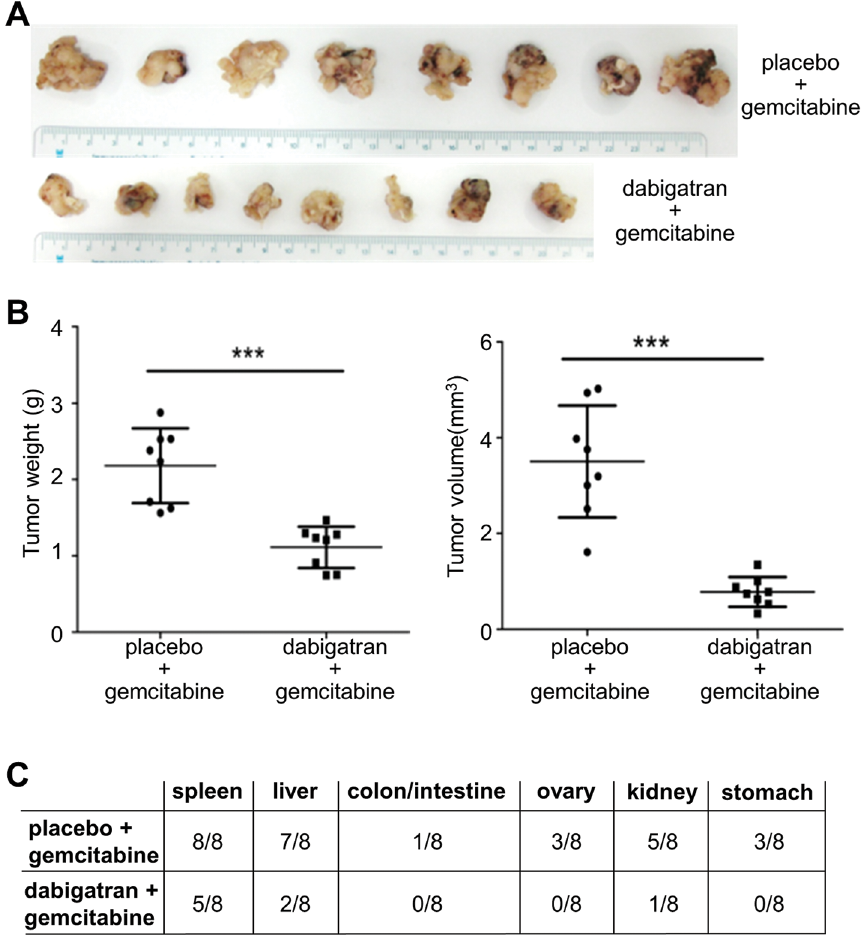
Figure 3. Effect of dabigatran in combination with gemcitabine on pancreatic cancer growth and tumor cell dissemination. (A) Pancreatic tumors derived 5 wks after tumor cell inoculation from gemcitabine- and dabigatran/gemcitabine-treated mice. (B) Weight and size of tumors depicted in (A). Indicated is the mean ± SEM (n = 8 mice per group). *** P < .0001. (C) Number of mice with distant metastasis in the indicated organs at the time of euthanization (8 mice per